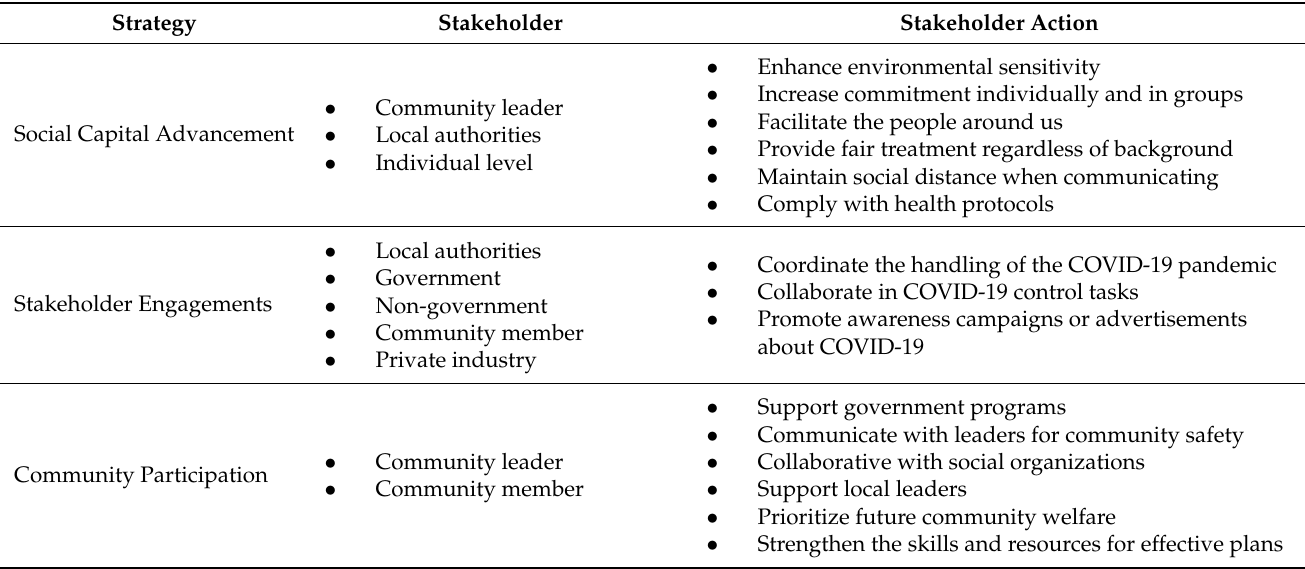
Figure 2. Stakeholder actions for COVID-19 risk management. Table 2. Recommended stakeholder action strategies for COVID-19 risk